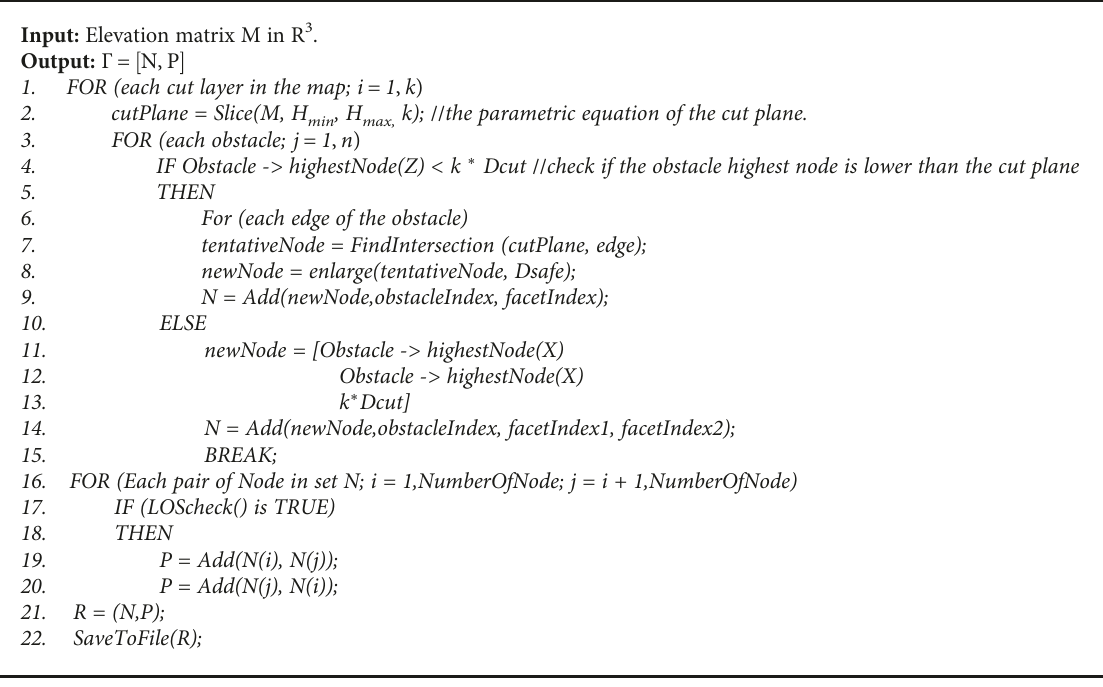
Algorithm 1. RoadmapCreate